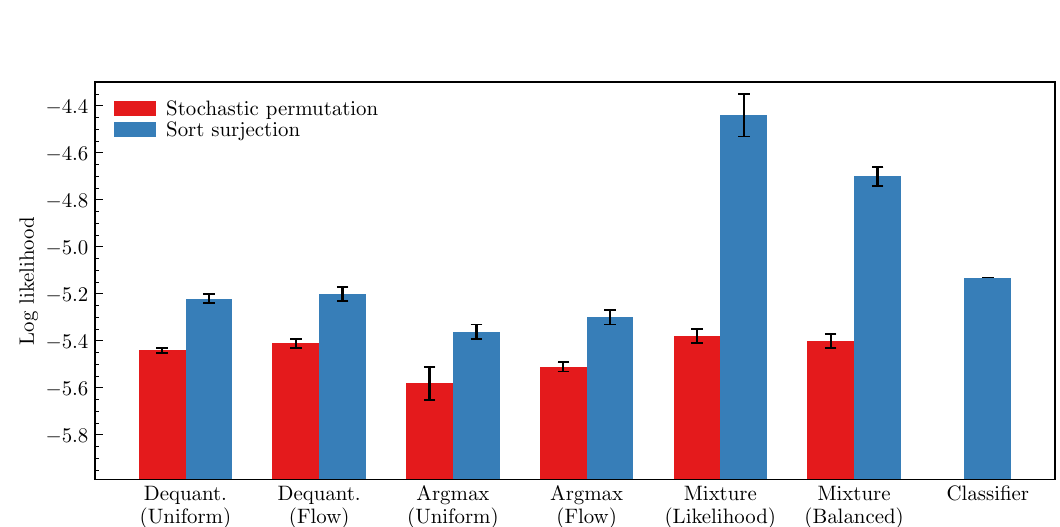
Figure 11: Test log likelihoods (higher is better) of various generative models for density estimation on mixed continuous-discrete data applied to four-gluino events, including helicity and colour labels. The bars show the average results over three independent runs, and the error bar indicates the standard deviation.